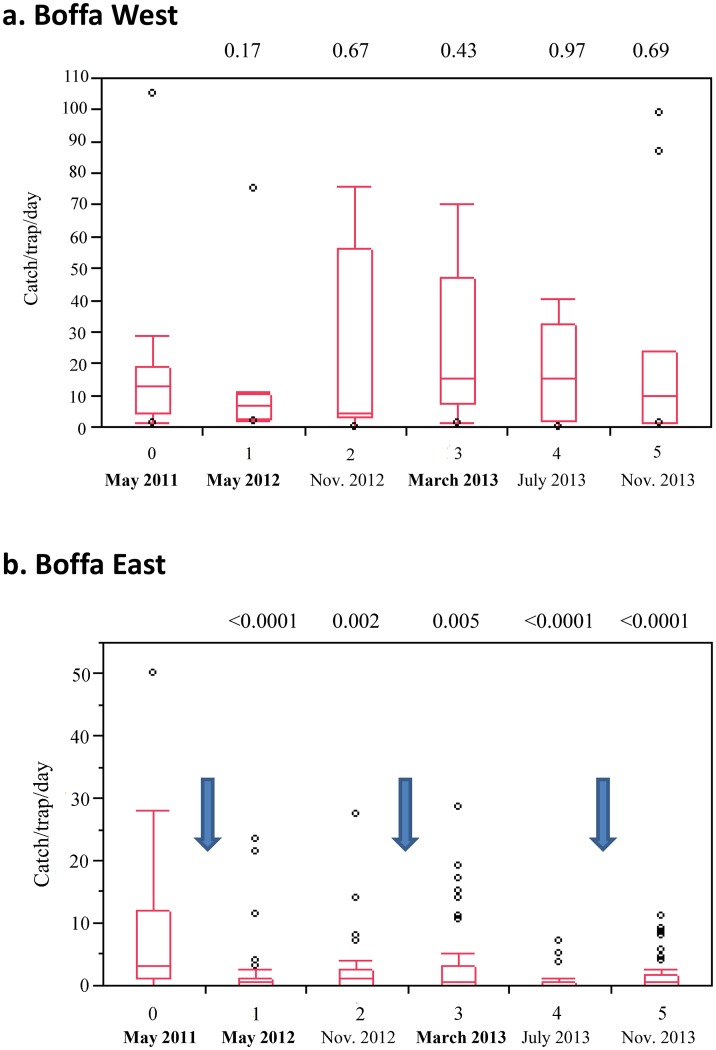
Evolution of tsetse densities during the study period in the Boffa focus.Box plots showing the median and 10th, 25th, 75th and 90th centiles of catches of tsetse from six sampling rounds (May 2011—November 2013) in Boffa West (a.) where no tsetse control intervention where initiated and Boffa East (b.) where insecticide-impregnated targets were deployed. Blue arrows indicate insecticide-impregnated target deployment/replacement. P-values of the difference between each monitoring round and pre-treatment data in May 2011 are indicated (Wilcoxon matched-pairs signed-rank test).